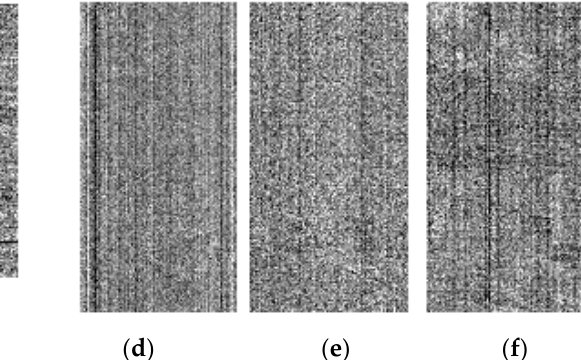
( f ) Figure 7. ( a – c ) Images of the Longkou area after MNF, ICA, and PCA transforms, respectively; ( d – f ) images of the Honghu area after MNF, ICA, and PCA transforms, respectively. 4.2. Accuracy Assessment The final accuracy evaluation is shown in Tables 1 and 2, which show that the clas- sification accuracy of the two regions was affected by many factors. Table 1. RF classification accuracy evaluation of random sample sets in the Longkou area. Random Sample Set